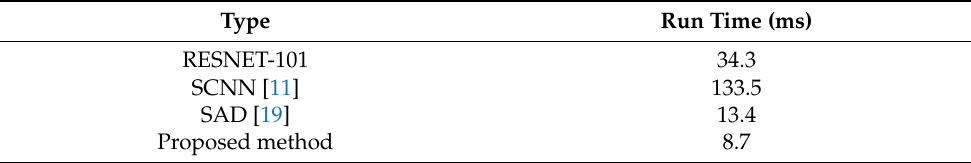
Table 5. The comparison of the runtime.